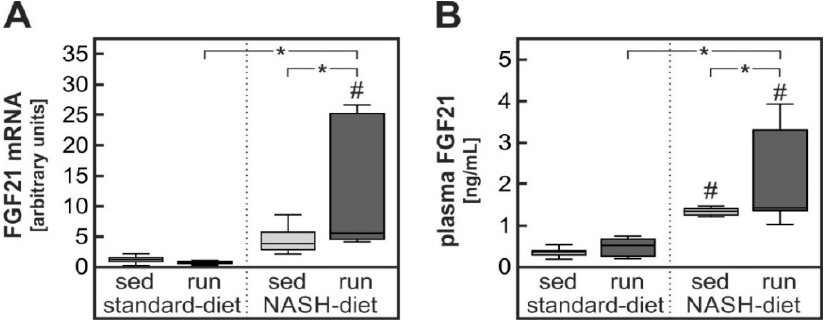
Figure 6. Diet- and exercise-dependent induction of hepatic FGF21 production. ( A ) Fibroblast growth factor 21 (FGF21) mRNA expression was quantified by RT-qPCR in liver samples from the different intervention groups described in the legend to Figure 1. ( B ) FGF21 plasma protein concentration was determined. Values are median (line), upper and lower quartile (box) and extremes (whiskers). Statistics: Two-way-ANOVA with Tukey’s post hoc test for multiple comparisons; #: significant versus sedentary standard-diet group, * p < 0.05 between compared groups.